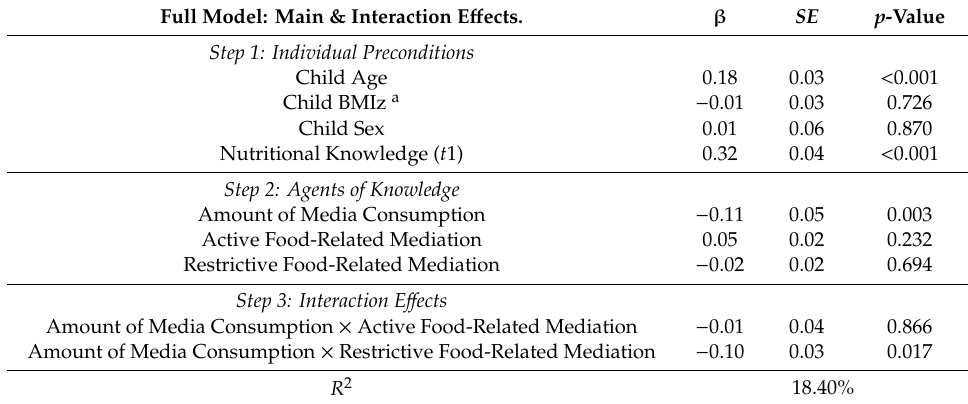
Table 1. Results for regression analysis predicting Time 2 of children’s nutritional knowledge. Full Model: Main & Interaction E ff